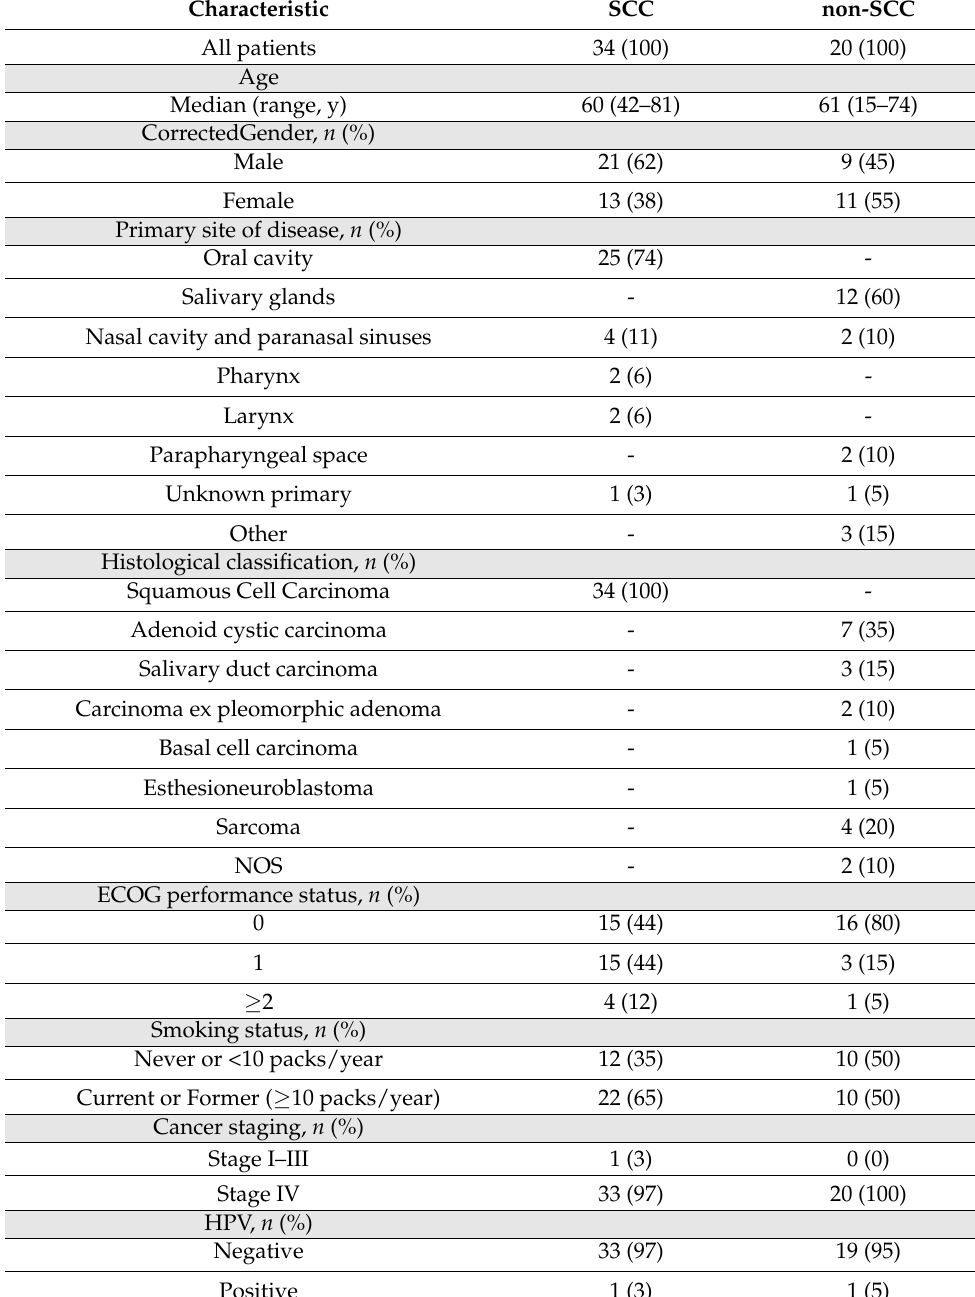
Table 1. Clinical characteristics in our institution. NOS, not otherwise